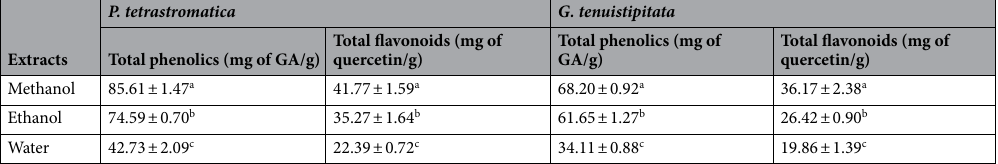
lybdenum: R 2 = 0.7509 (Fig. 3D), TFC-H 2 O 2 scavenging activity: R 2 = 0.8894 (Fig. 3E), TFC-NO scavenging: